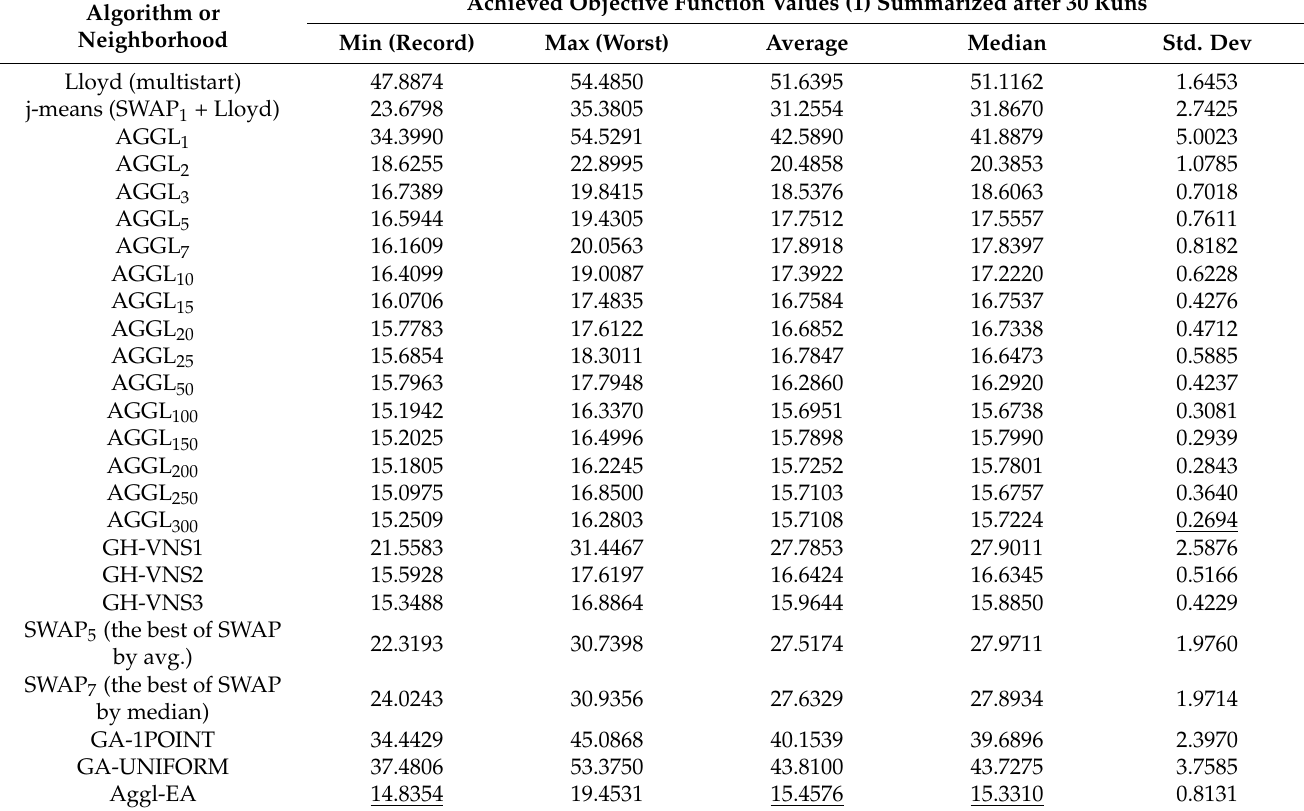
Table A10. Comparative results for Mopsi-Joensuu dataset. 6014 data vectors in R 2 , p = 300 centers, time limitation 5 s. Algorithm